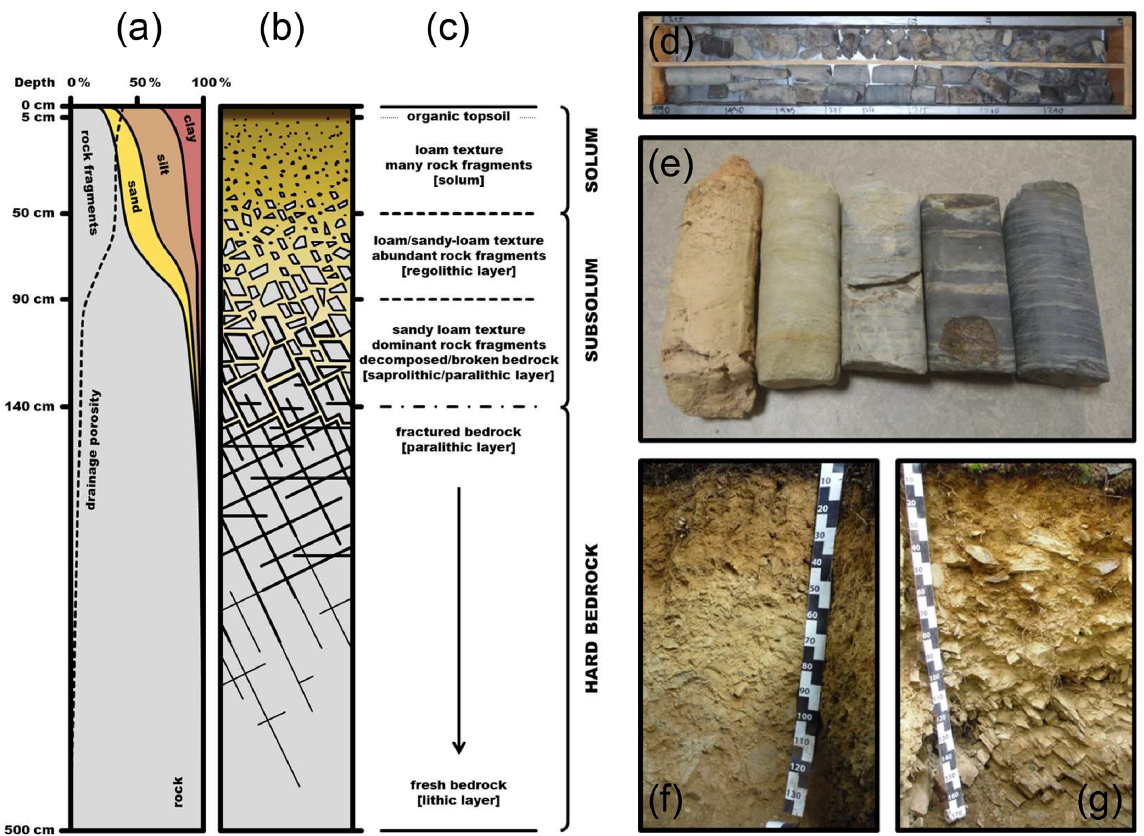
Figure 2. Synthesis scheme of the regolith in the Weierbach catchment (with (a) variations with depth of average drainage porosity and rock, sand, silt and clay contents, (b) sketch of the regolith and (c) description of regolith layers) and pictures of some “point-scale” investigation spots (with (d) cores from drilling carried out next to plot-scale ERT profile P04, (e) various aspects of the top of the substratum as revealed in deeper drillings, (f) soil pit dug next to plot-scale ERT profile P08 and (g) soil pit dug next to plot-scale ERT profile